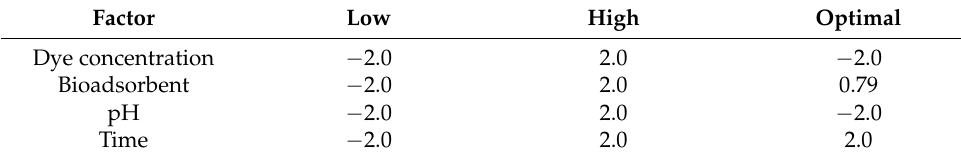
Table 5. Optimal operating conditions for the adsorption of Congo red dye. Factor Low